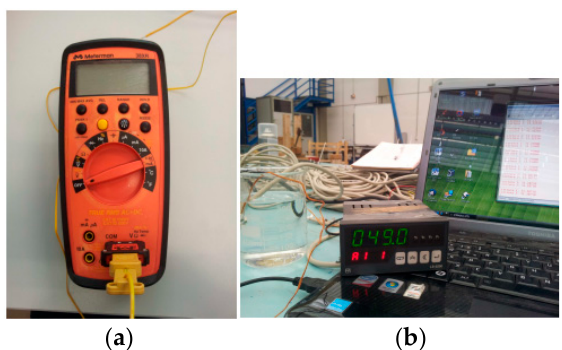
Figure 8. Thermocouples used for the sensor calibration. ( a ) TerEle, ( b ) TerEst.